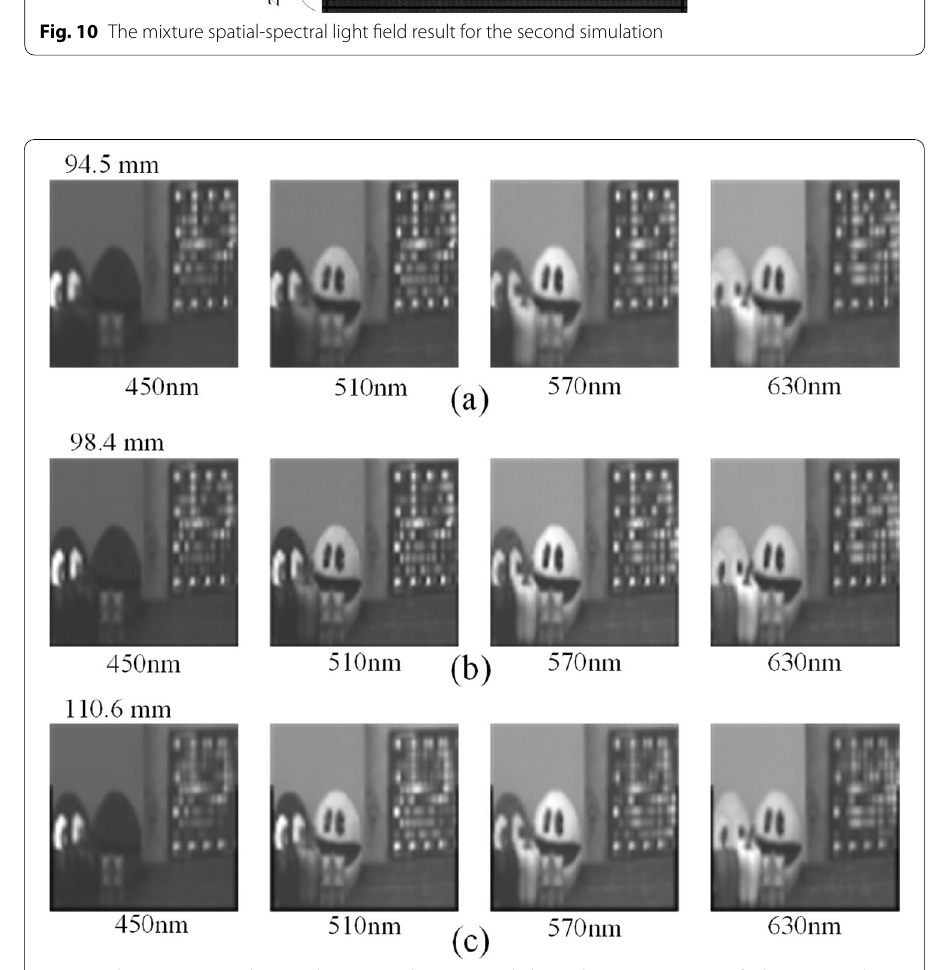
Fig. 11 The reconstructed spectral images, a the estimated object distance is 94.5 mm, b the estimated object distance is 98.4 mm, c the estimated object distance is 110.6